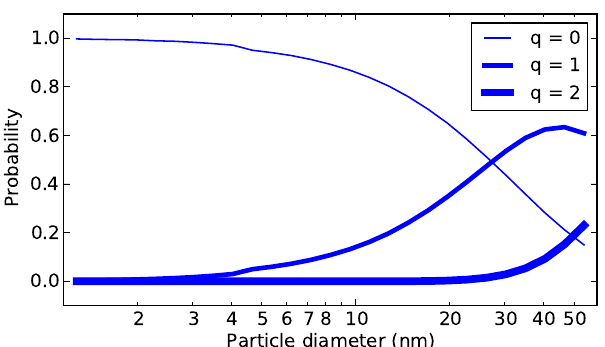
Fig. 3. The probability of particles having 0, 1 or 2 elementary charges after passing the main charger of the